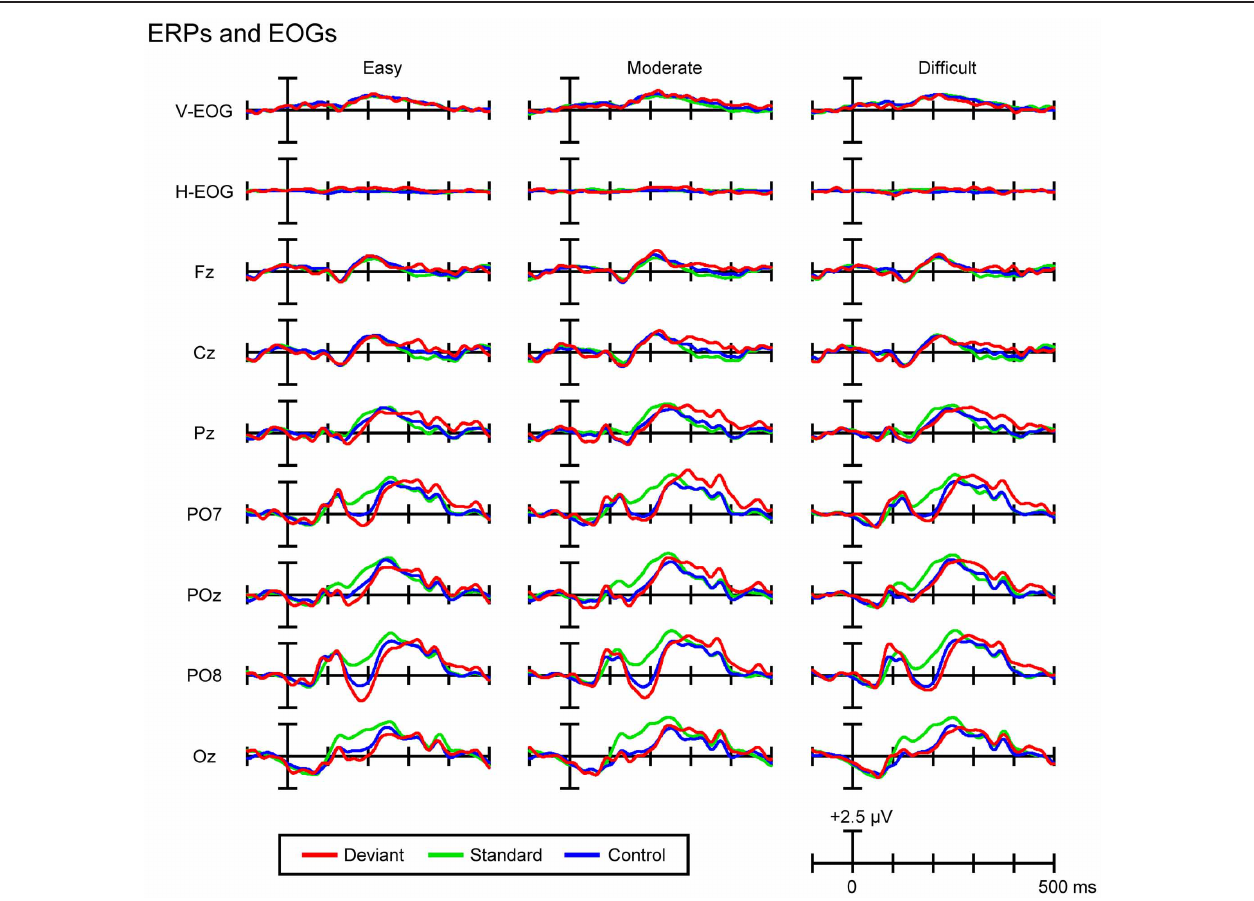
FIGURE 3 | Grand-average ERPs and EOGs in response to deviant, standard, and control stimuli in the easy (left column), moderate (middle column), and difficult conditions (right column).